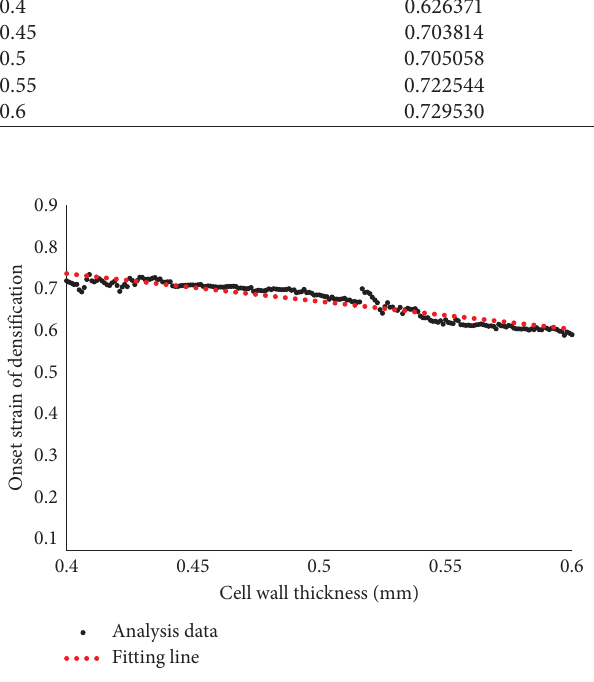
Figure 10: Influence of wall thickness on the onset strain of